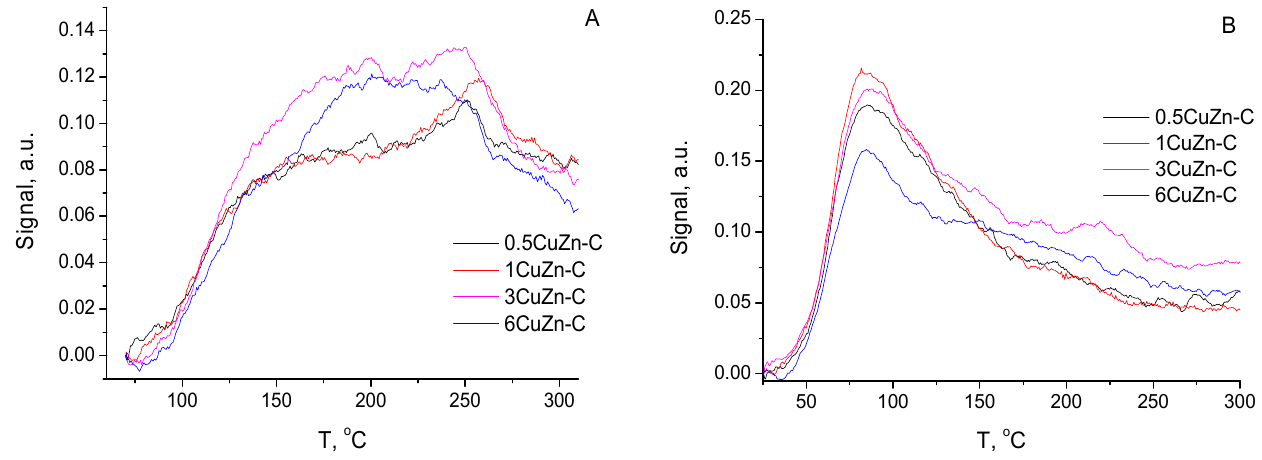
Figure 3. NH 3 -TPD ( A ) and CO 2 -TPD ( B ) spectra recorded for calcined CuZn samples varied in Cu/Zn